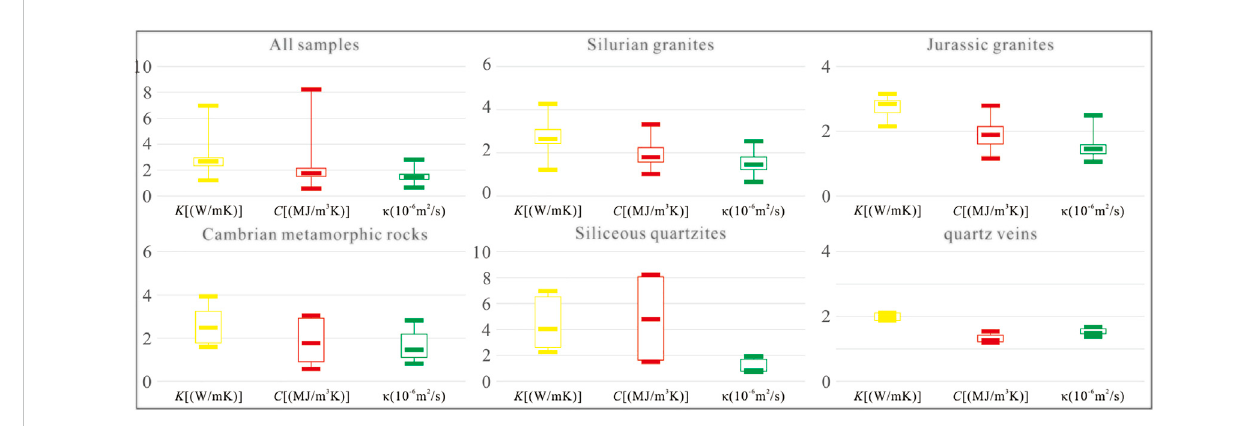
FIGURE 3 Boxplot of thermophysical parameters in the Wugongshan area (K, thermal conductivity; C , speci fi c heat capacity; κ , thermal diffusivity).